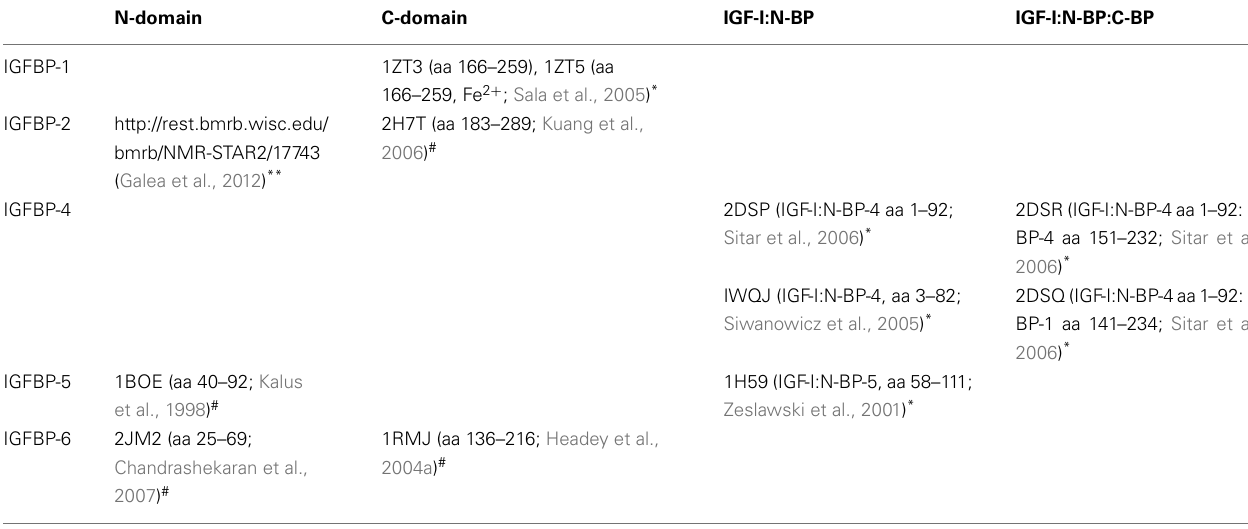
Table 1 | Structures of IGFBP domains found in the Protein Data Bank (PDB) and Biological Magnetic Resonance Bank (BMRB)